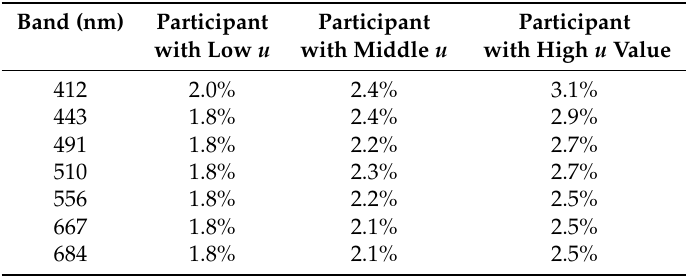
Table 4. Examples of participants’ radiance calibration relative uncertainty, k =